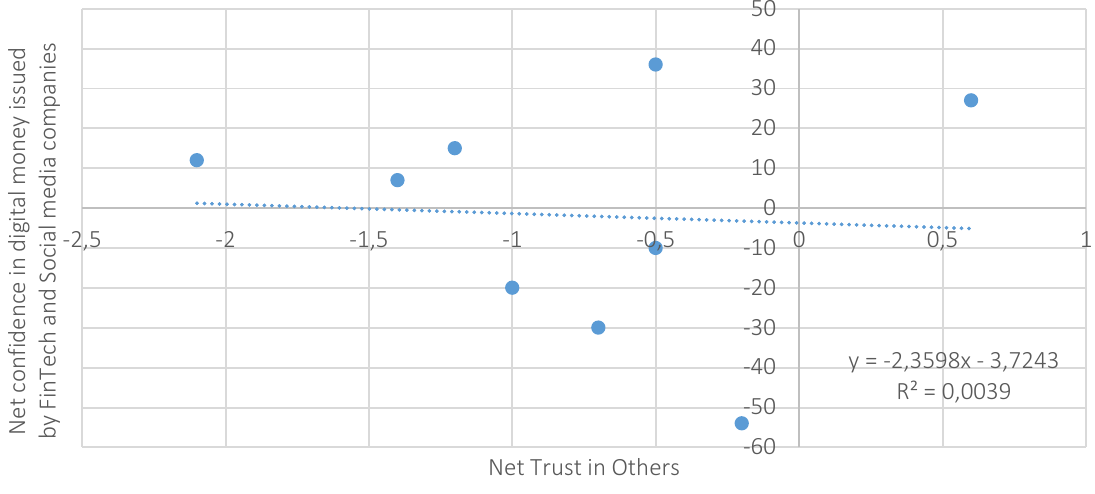
Figure B6. Confidence in privately issued digital money and social trust